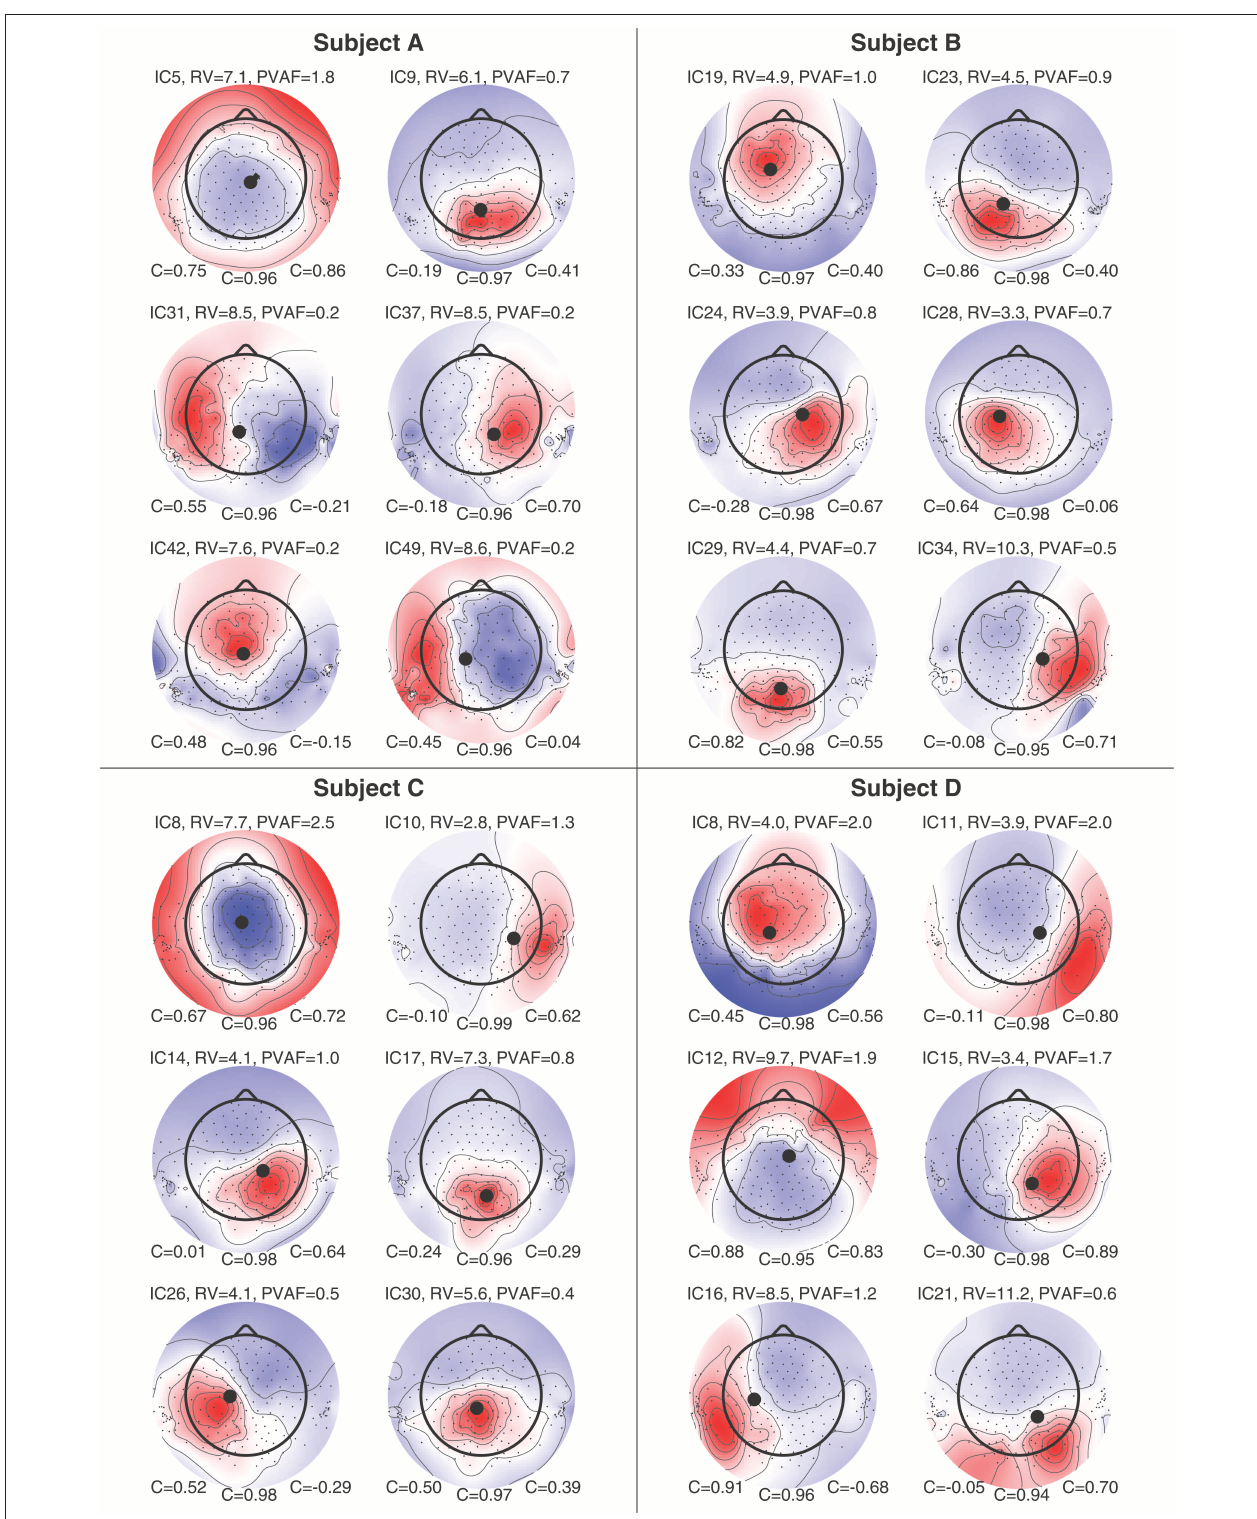
FIGURE 8 | Component maps for 6 ICs from each subject. Above each component map is shown the IC number, the residual variance (RV), and percent of variance accounted (PVAF). Below each component map is given the Pearson’s correlation coefficient for the left ear, the scalp, and the right ear, respectively.